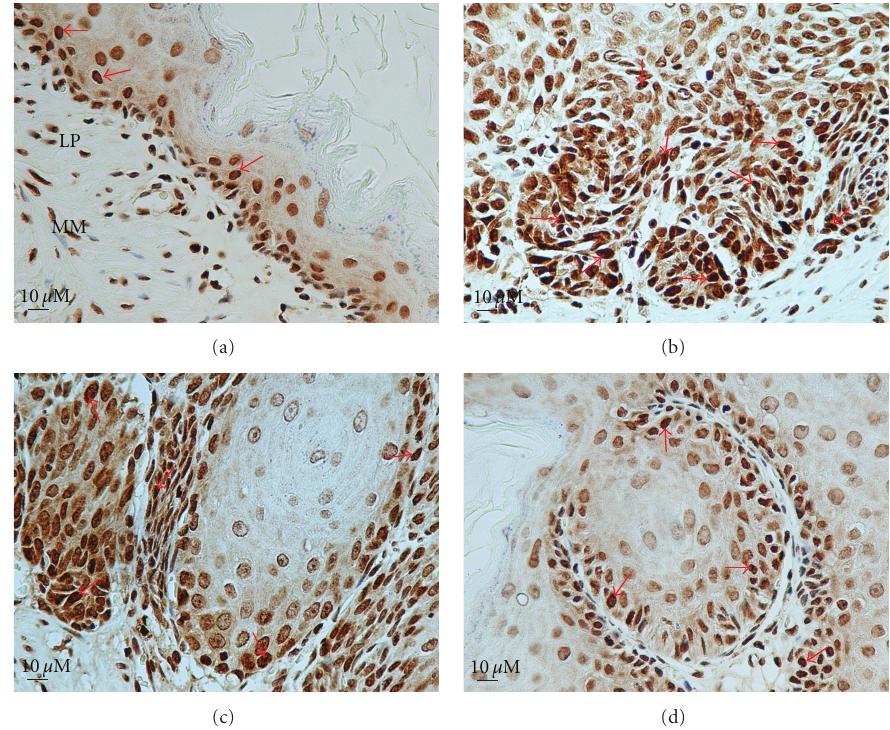
Figure 3: Immunohistochemical staining of 8-OHdG antibodies in the representative tissue specimens (400x): CO group (a), MNU + s-NaCl group (b), C20W cancer group (c), and C20W benign group (d). DAB stained immunoreactive cells (dark brown, arrows); nuclear counterstaining was performed with Hematoxylin II and Bluing reagent. LP: laminar propria and MM: muscularis